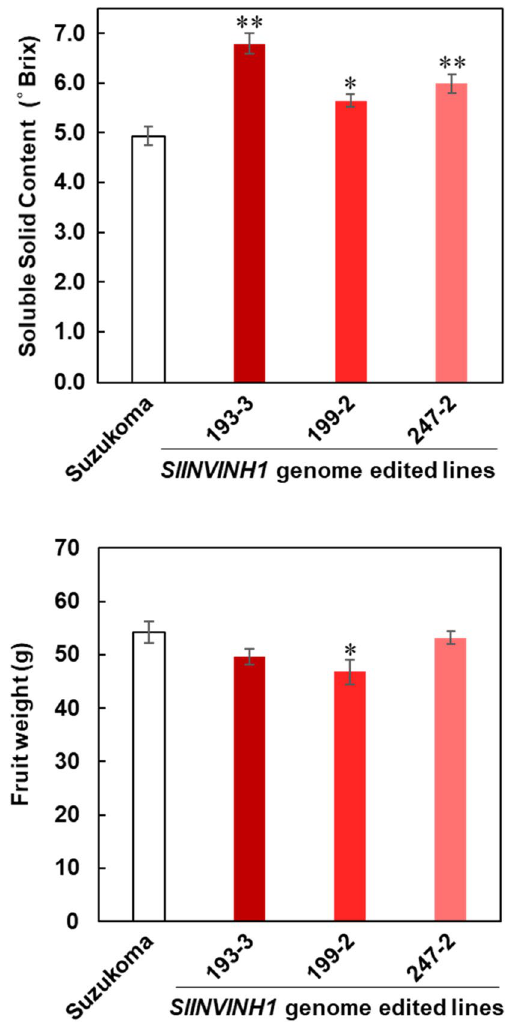
Figure 4. SSC and weight of fruits from the SlINVINH1 genome edited lines. ( a ) SSC of fruits at mature stage from original cultivar ‘Suzukoma’ and the SlINVINH1 genome edited lines (193–3, 199–2, and 247–2). Error bars indicate standard error for 15 fruits from 5 plants. An asterisk indicates a significant difference (Dunnett’s test, * P < 0.05; ** P < 0.01). ( b ) Fruit weight at mature stage from original cultivar ‘Suzukoma’ and the SlINVINH1 genome edited lines (193–3, 199–2, and 247–2). Error bars indicate standard error for 15 fruits from 5 plants. An asterisk indicates a significant difference (Dunnett’s test, * P <